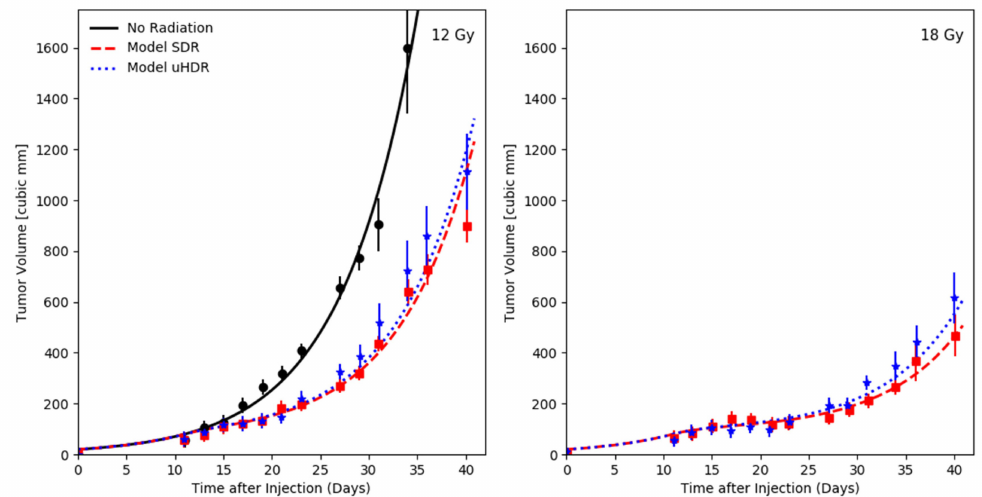
Figure 1. Growth kinetics of tumors in the flank of mice induced by injection of pancreatic tumor cells (MH641905) taken from Diffenderfer et al. [21] with respective UNIVERSE predictions. The tumors received either no radiation (black) or were irradiated 10 days after injection at the entrance of a 230 MeV proton beam, giving either 12 ( left ) or 18 Gy ( right ) at 63 Gy/s (uHDR, blue) or 0.74 Gy/s (SDR,